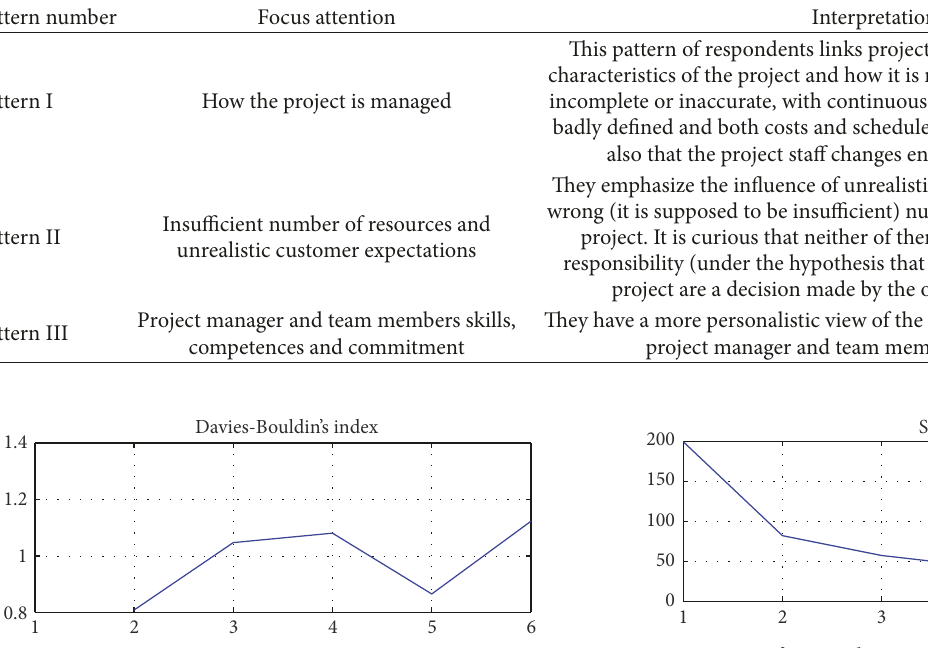
Figure 5: Davies-Bouldin’s index using a hexagonal 7 × 5 SOM calculated for each clustering ( 𝑥 -axis: number of clusters/ 𝑦 -axis: Davies-Bouldin’s index).